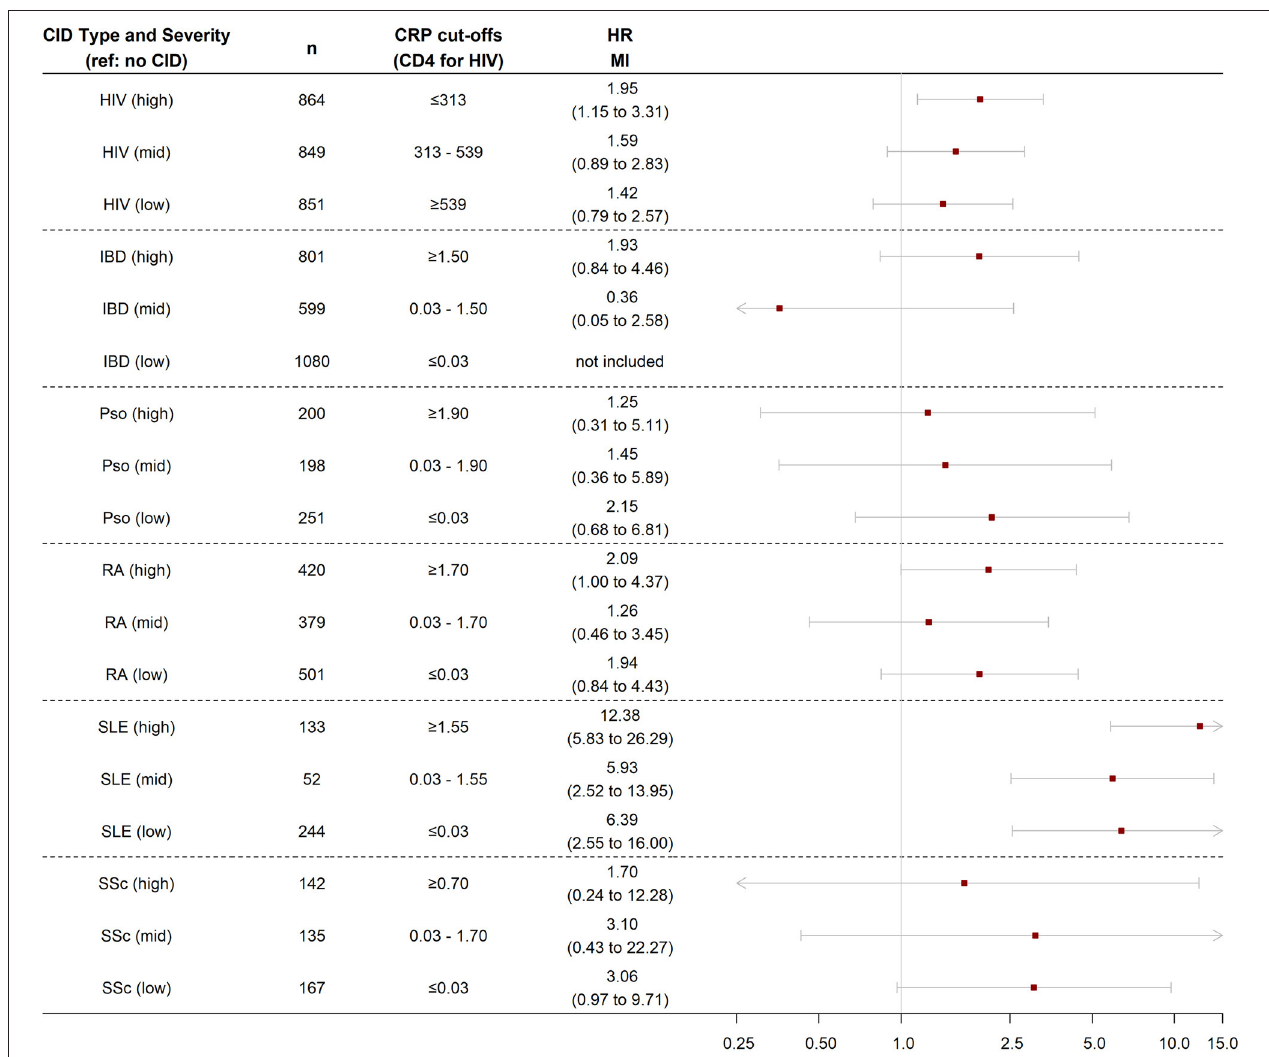
FIGURE 4 | Risk of incident myocardial infarction among chronic inflammatory disease groups stratified by disease severity. Analysis performed in nested cohort. Cox proportional hazard ratios adjusted for age, sex, race/ethnicity, insurance, baseline year, hypertension, diabetes, current smoking, statin use, and systemic steroid use. MI, myocardial infarction; HR, hazard ratio; CID, chronic inflammatory disease; HIV, human immunodeficiency virus; RA, rheumatoid arthritis; SLE, systemic lupus erythematosus; SSc, systemic sclerosis; IBD, inflammatory bowel